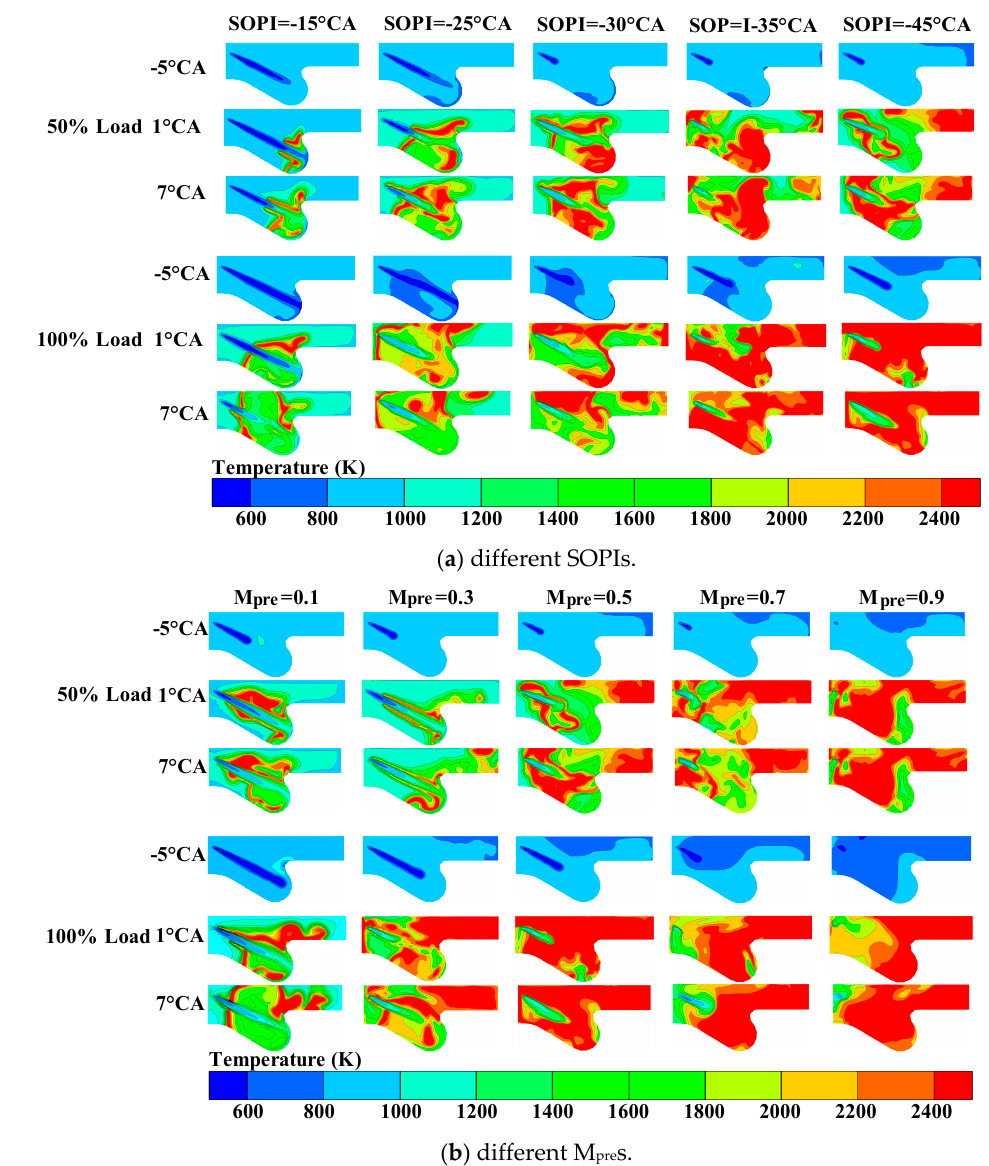
Figure 10. Comparisons of the cylinder temperature distribution field under different load condi- tions.